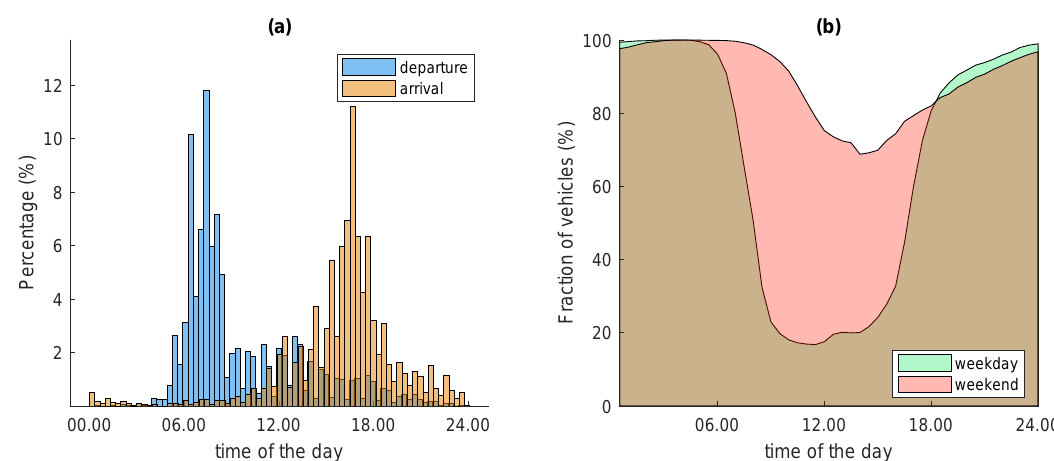
Figure 3. User mobility statistics: ( a ) time of home-arrival and home-departure and ( b ) mean daily fraction of vehicles parked at home. In ( b ), the light green area represents the weekday fraction, the light red area the weekend fraction, and the brown area just the intersection area between the two